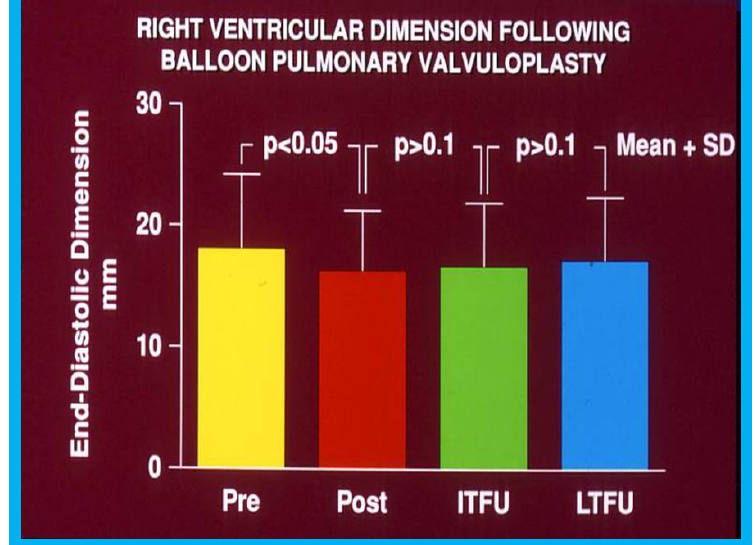
Figure 14. Graph showing end diastolic dimension of the right ventricle (RV) prior to (Pre), one day following (Post), at intermediate-term (ITFU), and at long-term (LTFU) follow-up after balloon pulmonary valvuloplasty (BPV). A significant reduction ( p < 0.05) in RV size immediately after BPV was seen. No further change at ITFU and LTFU occurred. Increased ( p < 0.05) prevalence of flat septal motion was observed at LTFU (see Figure 16). None of the patients had paradoxical septal motion. Mean + standard deviation (SD) are depicted. Reproduced from Rao P.S., et al. [16].